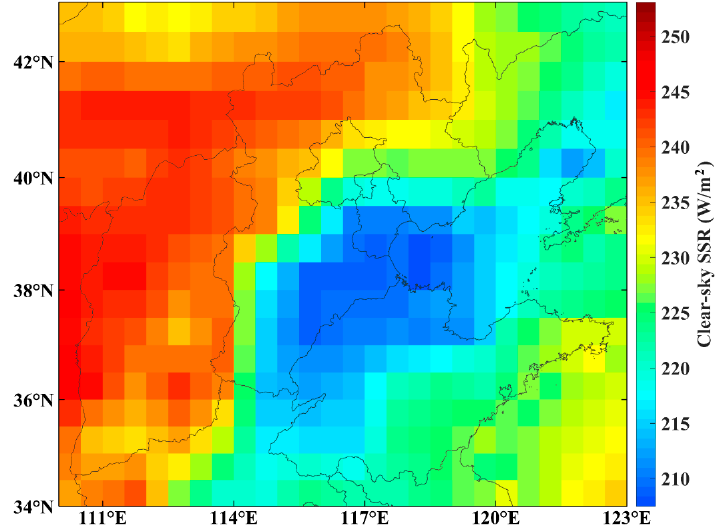
Figure 3. Spatial distribution of annual averaged clear-sky SSR in northern China from 2001 to 2015.